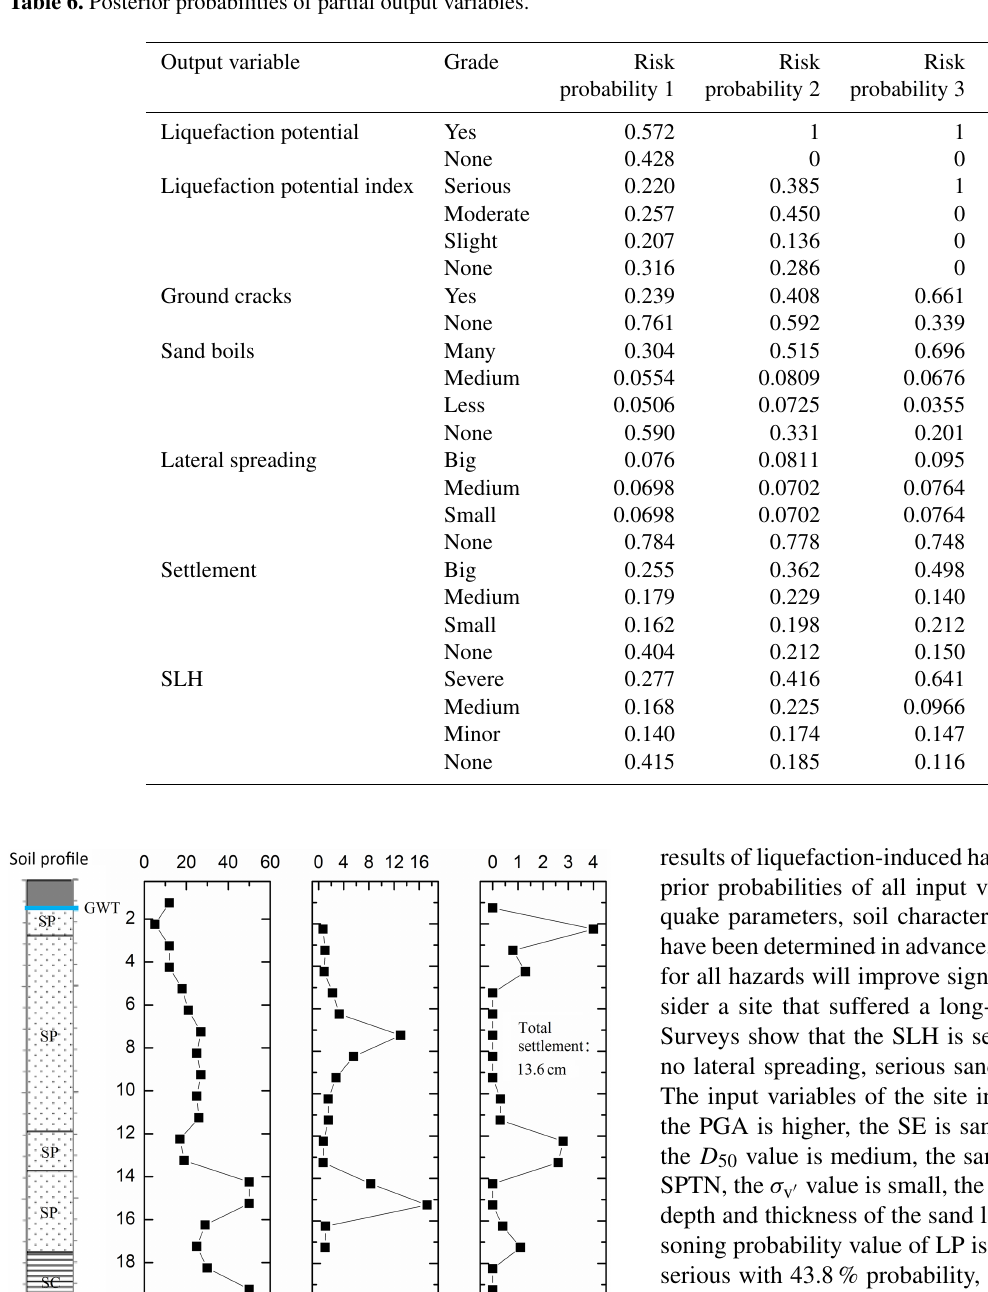
Table 6. Posterior probabilities of partial output variables.